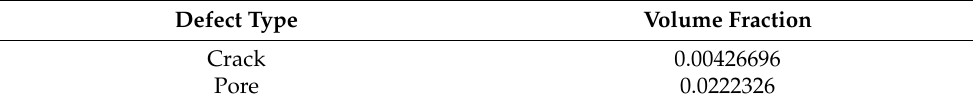
Table 4. Defect characterization inside the